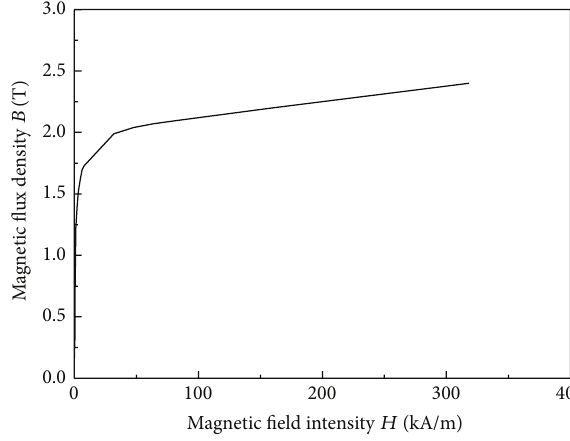
Figure 4: 𝐵 - 𝐻 curve of steel material (number 10).